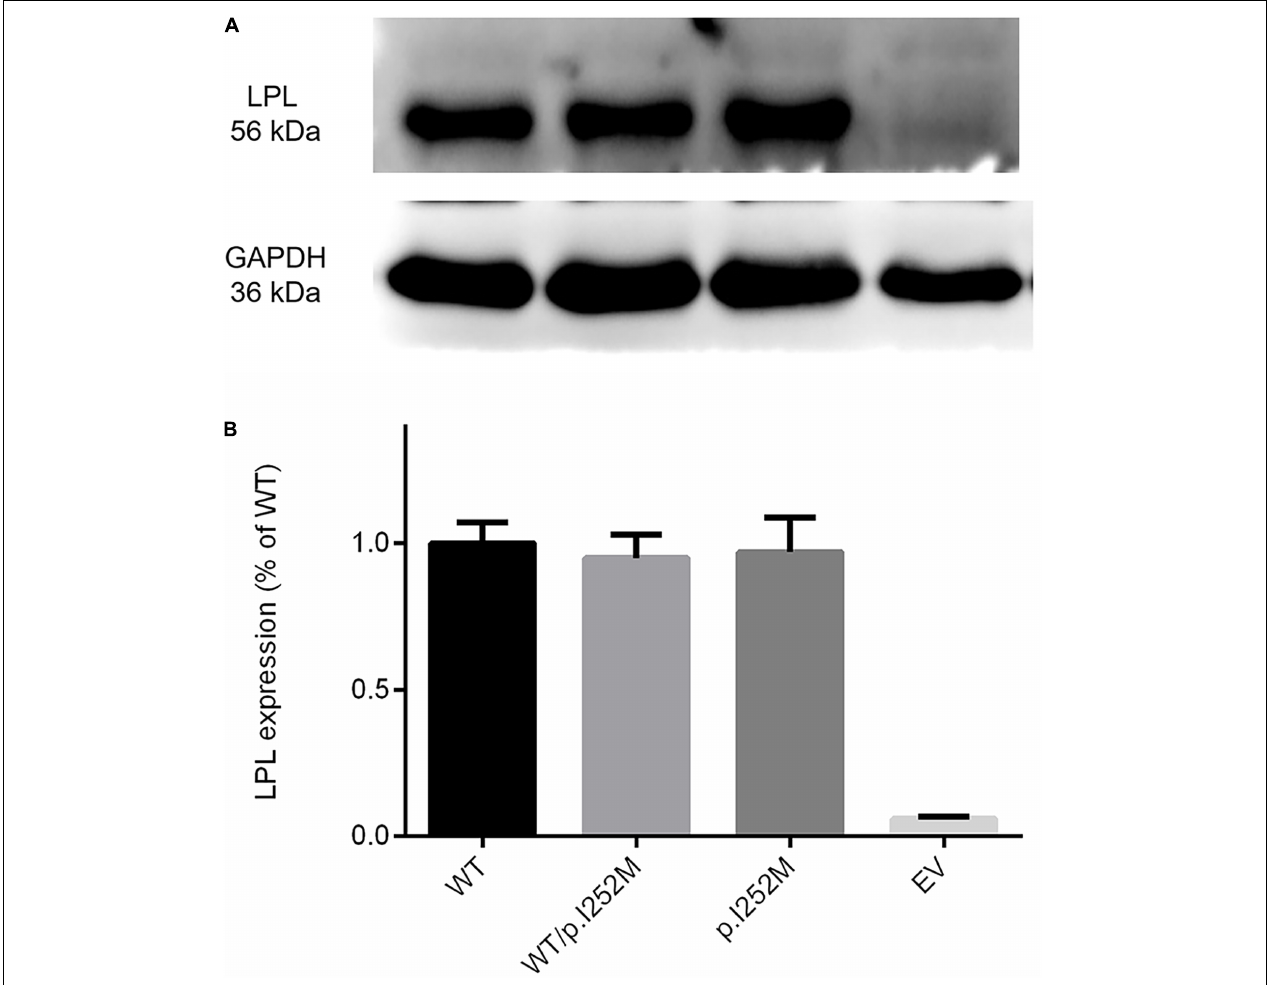
FIGURE 4 | Western blot analysis of LPL expression in transfected HEK293T cells without heparin treatment. (A) Results were the average taken from three independent experiments. (B) LPL, lipoprotein lipase; WT, wild-type; EV, empty